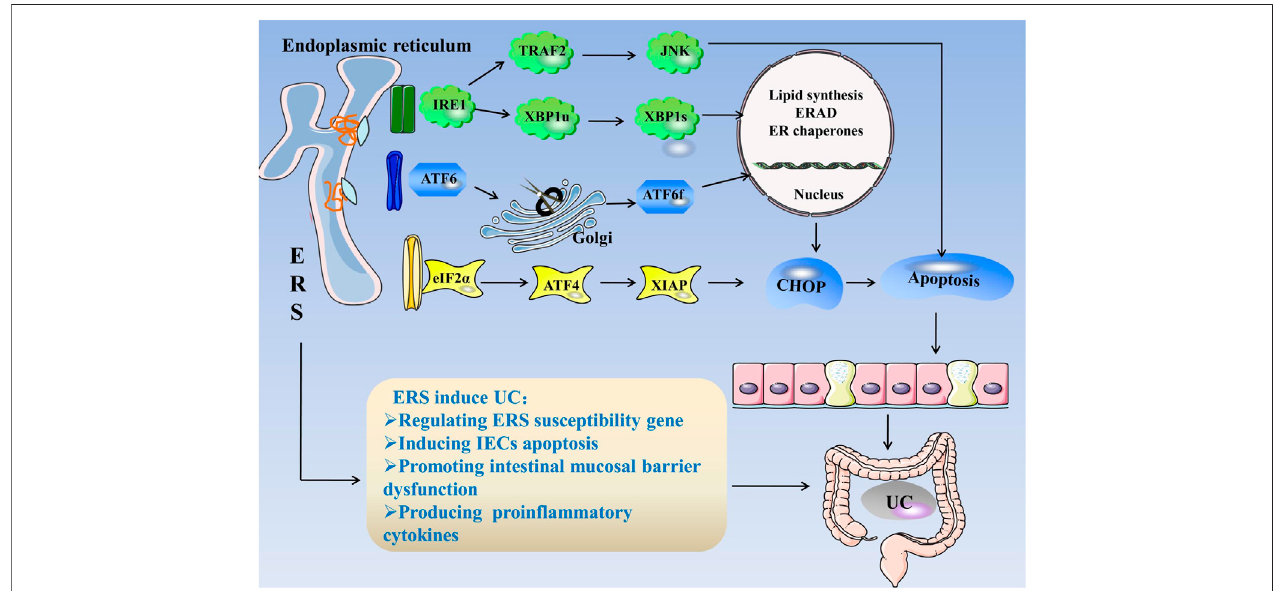
FIGURE 1 | ERS in UC. When unfolded or misfolded proteins accumulate excessively in the ER, ERS occurs and the UPR is initiated. The UPR consists of three pathways: IRE1, PERK, and ATF6. When the cell is in steady state, the three stress-related proteins bind to GRP78. When ERS occurs, GRP78 dissociates from three kindsofreceptorsandactivatestheIRE1,PERK,andATF6pathways.1)IRE1cleavesXBP1uintomorestableXBP1s,andIRE1canbindtoTRAF2toactivateJNK.The factors related to ER folding, lipid biosynthesis, and ERAD are regulated during the IRE1 reaction. 2) PERK activates eIF2 α through autophosphorylation, eIF2 α activates ATF4, and ATF4 induces CHOP expression, which is a cytokine that promotes apoptosis. 3) ATF6 is cleaved in the Golgi apparatus and binds to speci fi c DNA to regulate CHOP. ERS regulates ERS susceptibility genes, induces IEC apoptosis, destroys the intestinal mucosal barrier, and produces proin fl ammatory cytokines, leadingtoUC. Abbreviations: ATF,activating transcription factor;CHOP, C/EBPhomologousprotein;ER,endoplasmicreticulum;ERS,endoplasmicreticulumstress; ERAD,endoplasmicreticulumassociateddegradation;eIF2 α ,eukaryoticinitiationfactor2 α ;GRP78,glucose-regulatedProtein78;IECs,intestinalepithelialcells;IRE1 α , inositol-requiring enzyme 1; JNK, c-Jun N-terminal kinase; PERK, protein kinase R-like endoplasmic reticulum kinase; TRAF2, tumor necrosis factor receptor – associated factor 2; XBP1, X-box-binding protein 1; UC, ulcerative colitis; UPR, unfolded protein